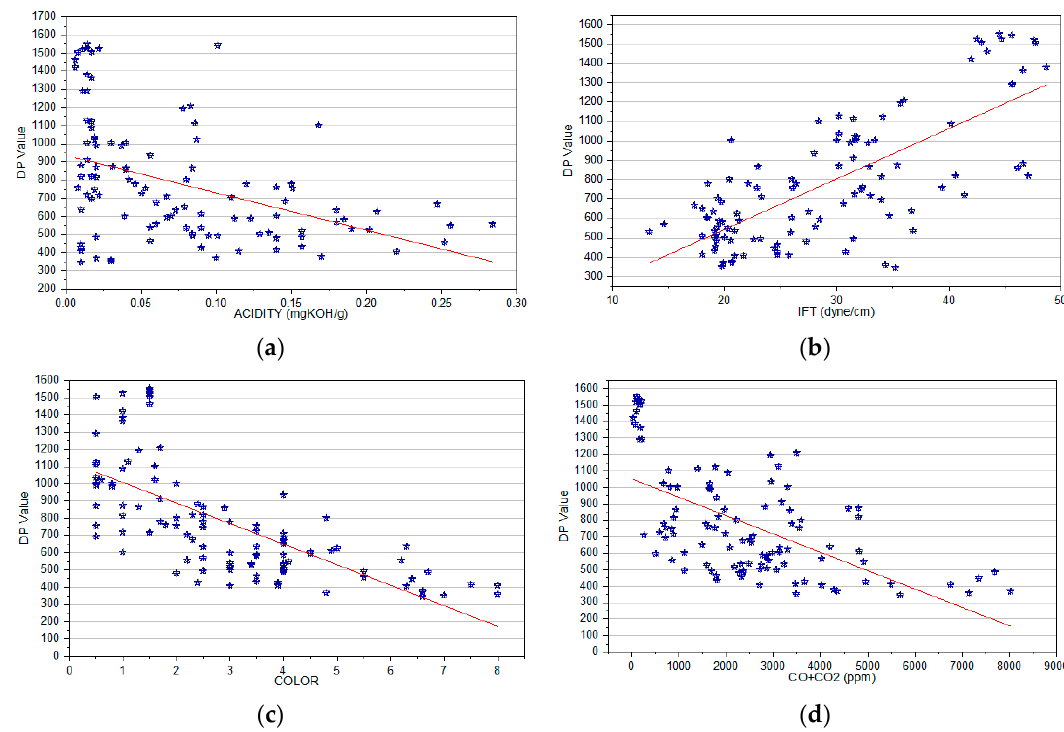
Figure 4. Scatterplots of DP (Degree of Polymerization) estimated versus input variables. ( a ) DP versus Acidity; ( b ) DP versus Interfacial Tension; ( c ) DP versus Color; ( d ) DP versus CO + CO 2 .